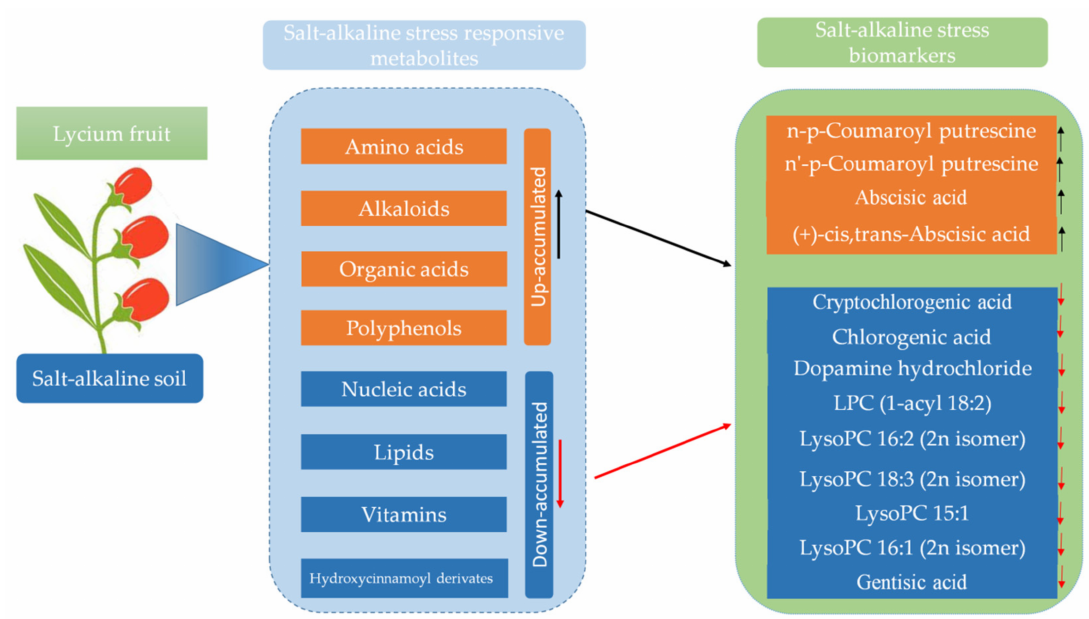
Figure 6. Summary of the metabolic responses to salt-alkaline stress in Lycium barbarum fruit. Under salt-alkaline stress, several classes of metabolites are upregulated or downregulated: salt-alkaline responsive metabolites. Thirteen metabolites are constitutively differentially accumulated across various salt-alkaline stress gradients: salt-alkaline stress biomarkers. The black arrow stands for upregulated metabolites while the red arrow stands for downregulated